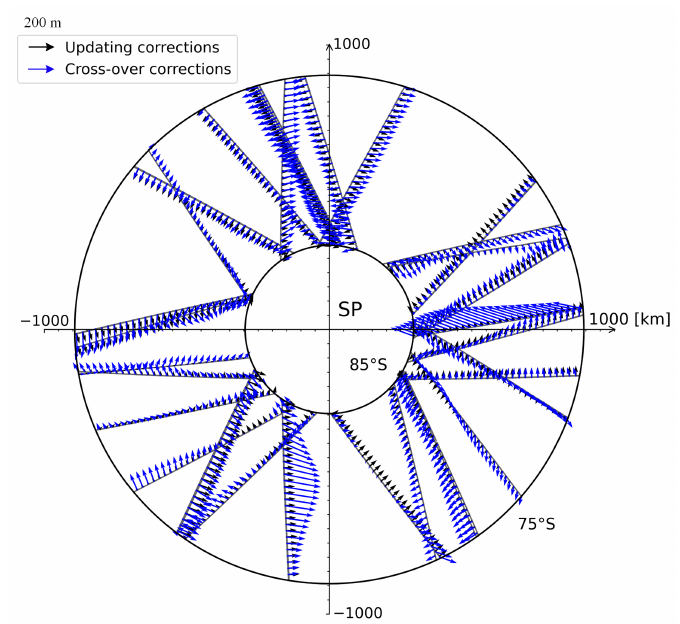
Figure 12. Lateral vectors of the reprocessing updates from the updated orbit and Mars rotational model (black) and corrections from the global cross-over analysis (blue) for 15 randomly selected profiles in the south pole. Note that the length of the arrows within the legend corresponds to 200 m in displacement. The projection is stereographic centered at the south